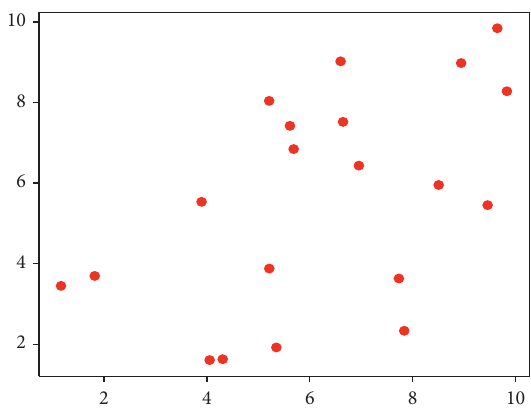
Figure 6: Random points graph of zone (1, 10).